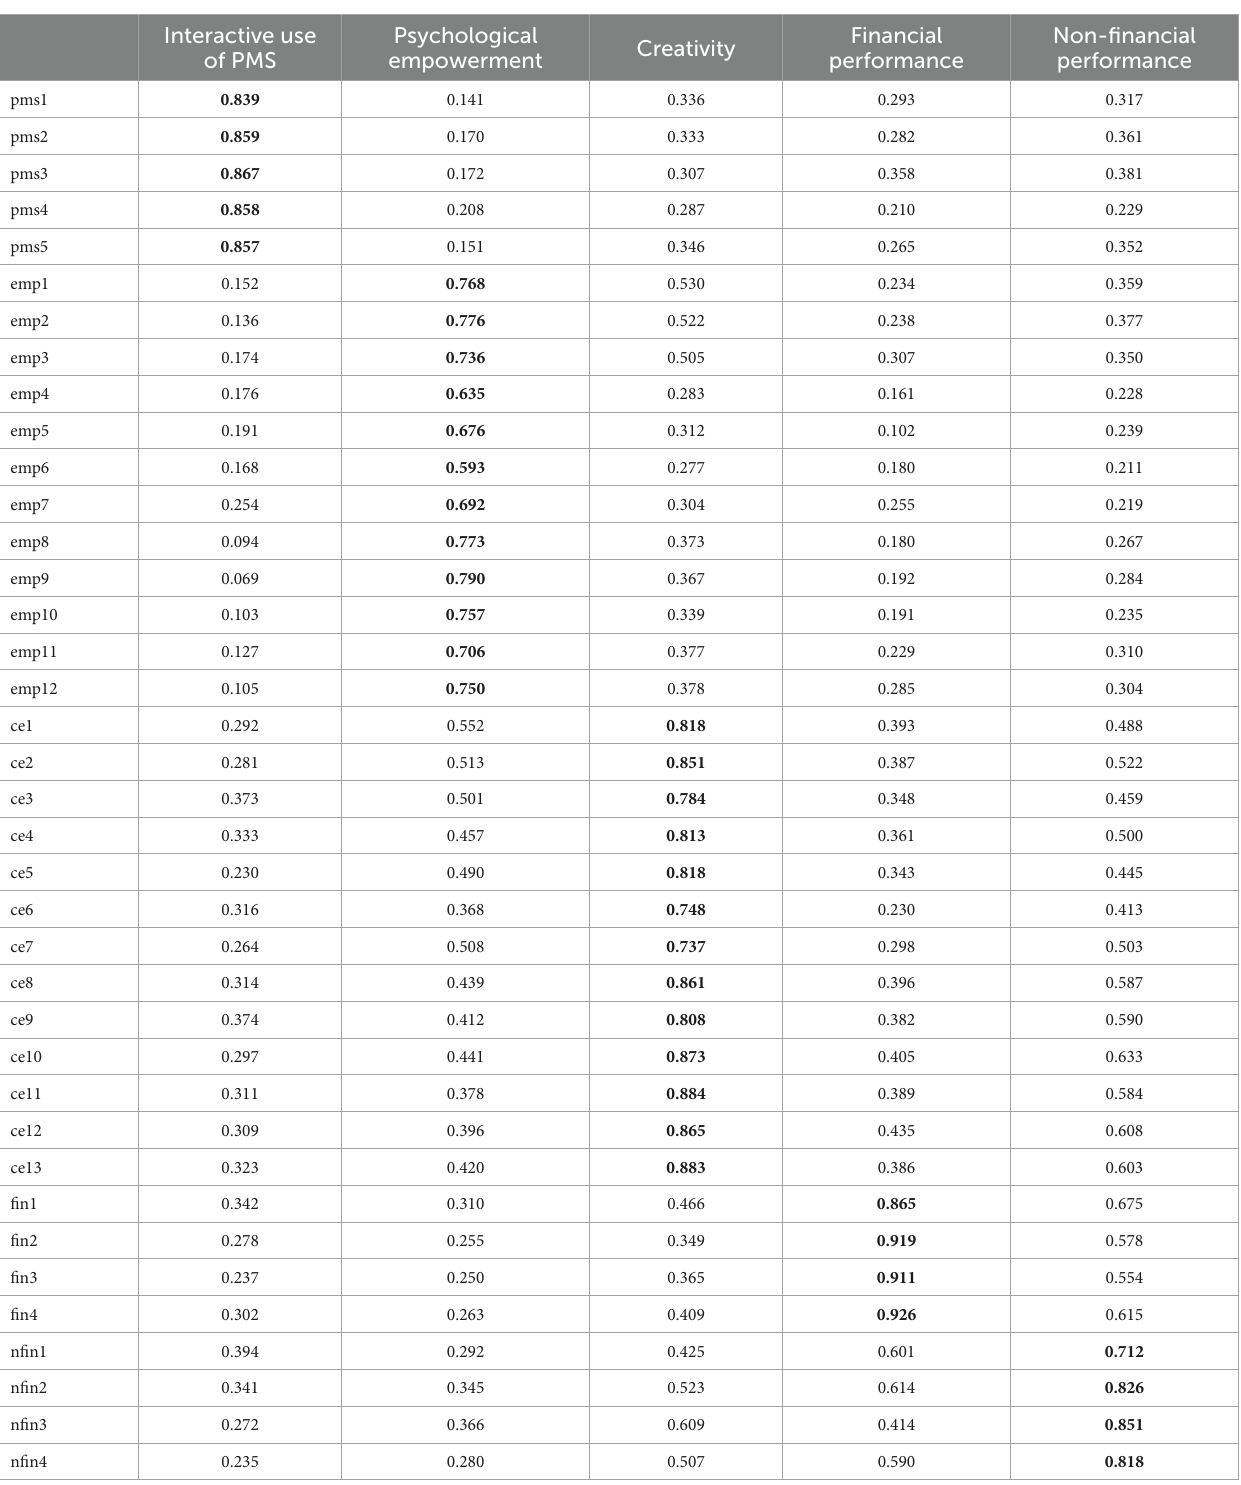
TABLE 2 Factor loadings from the PLS measurement model.